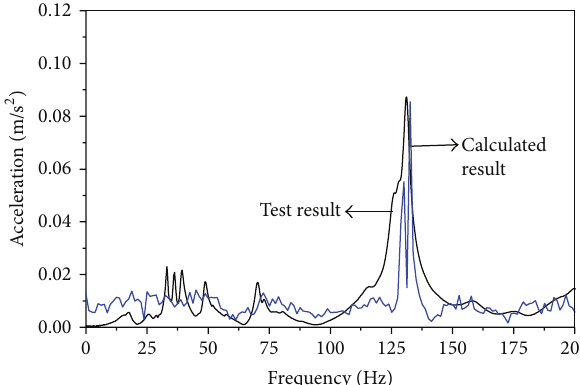
Figure 9: Time history of the vibration acceleration of the middle supporting platform.